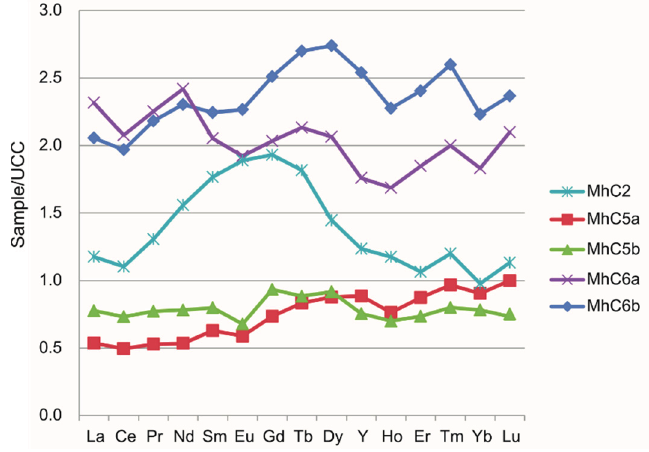
Figure 5. Distribution patterns of REY in the Mahe coal samples. REY are normalized by Upper Continental Crust (UCC)